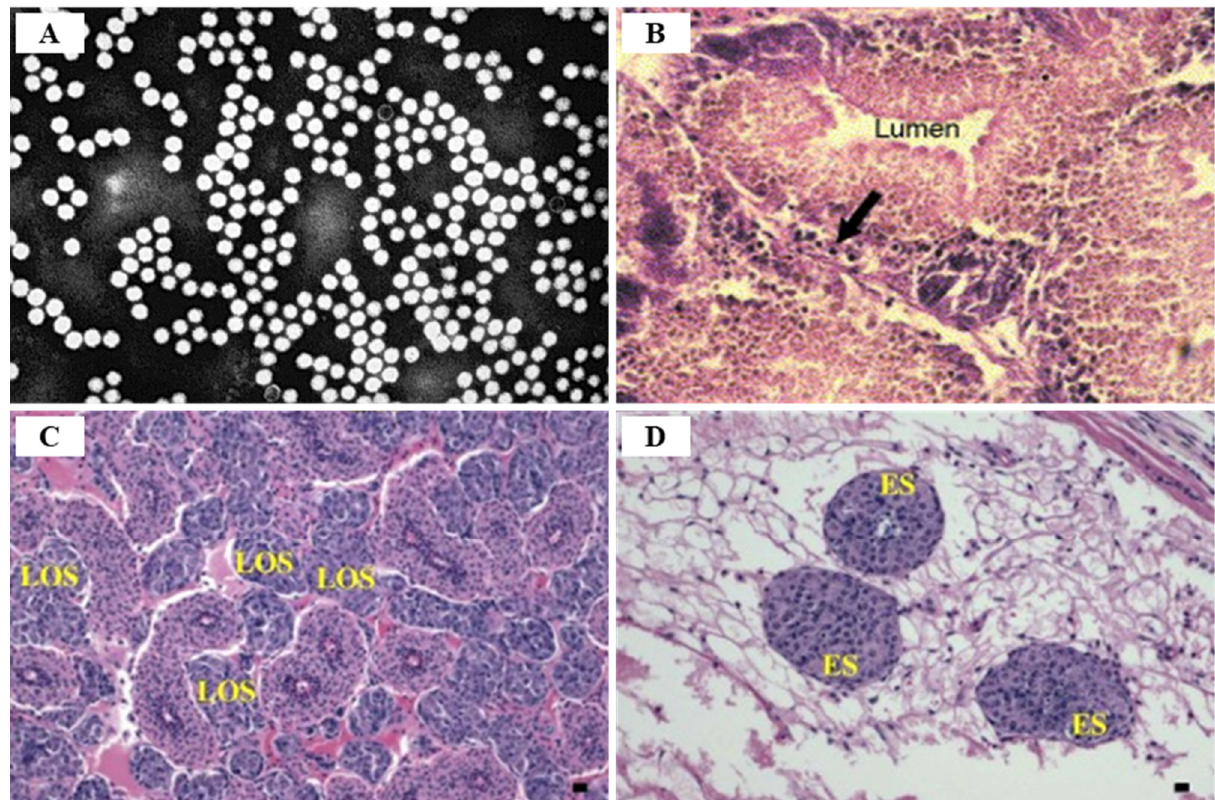
Figure 20. Electron microscopy and histological changes in shrimp infected with Taura syndrome virus (TSV). ( A ) TEM of CsCl gradient-purified and negative-strained (with 2% PTA) TSV particle isolated from Penaeus vannamei in Ecuador; ( B ) the section of intestine with 400 × magnification has cytoplasmic inclusion bodies in the lymphoid organ of Penaeus monodon (arrow); ( C , D ) spheroids (LOS) in the lymphoid organ tissue and ectopic spheroids in the connective tissue of P. vannamei from Venezuela, when stained with H&E, respectively (Scale bar = 25 µm). (( A ) Reprinted from Advances in virus research, Vol. 63, Dhar, A.K., Cowley, J.A., Hasson, K.W., Walker, P.J., Genomic organization, biology, and diagnosis of Taura syndrome virus and yellowhead virus of penaeid shrimp, p. 69, Copyright (2004), with permission from Elsevier; ( B ) Reprinted from Aquaculture, Vol. 260 (1 – 4), Phalitakul, S., Wongtawatchai, J., Sarikaputi, M., Viseshakul, N., The shrimps of Thailand, p. 9, Copyright (2006), with permission from Elsevier; ( C , D ) Reprinted from Aquaculture, Vol. 480, Tang, K.F., Aranguren, L.F., Piamsomboon, P., Han, J.E., Maskaykina, I.Y.,